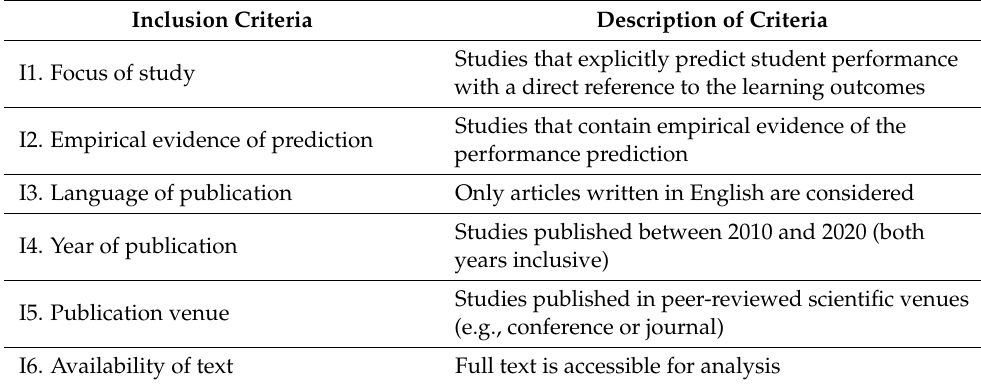
Table 3. Inclusion criteria in our systematic literature